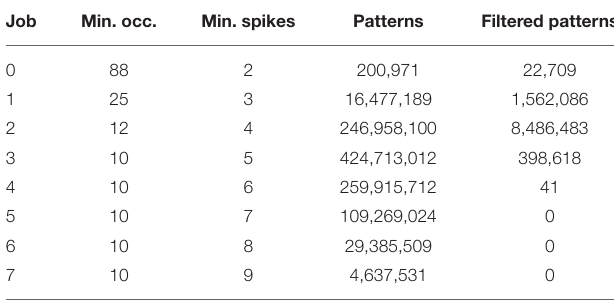
TABLE 1 | Configurations of the eight jobs used for the evaluation. Job Min. occ.